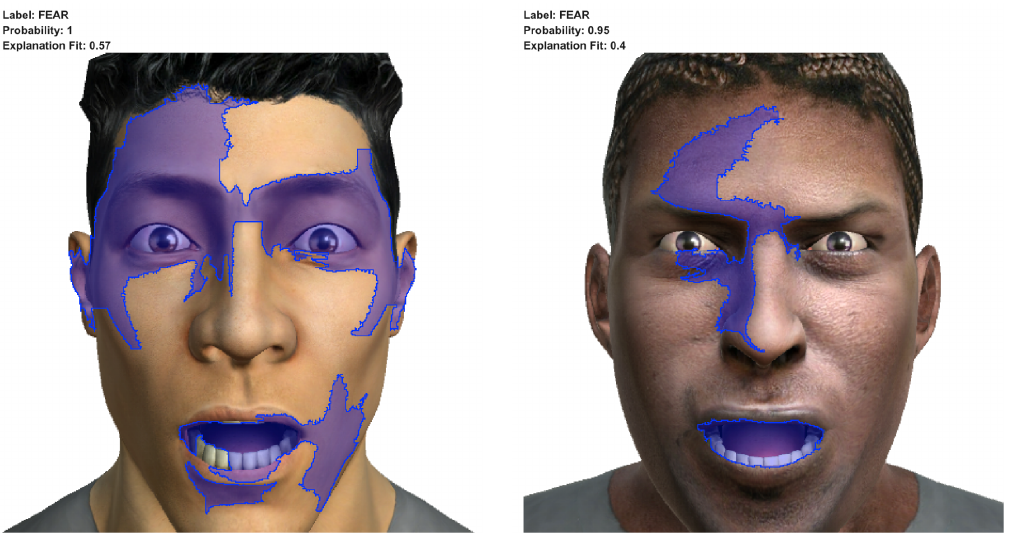
Figure 8. Results of applying LIME to images of fear correctly labelled as the emotion of fear. The left one corresponds to the facial expression very frightened , and the right one corresponds to the facial expression terror .